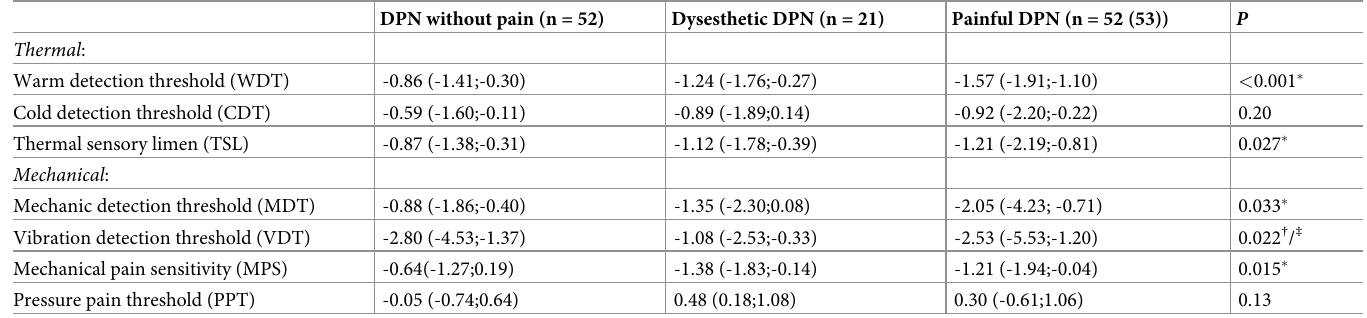
Table 4. Quantitative sensory testing, median